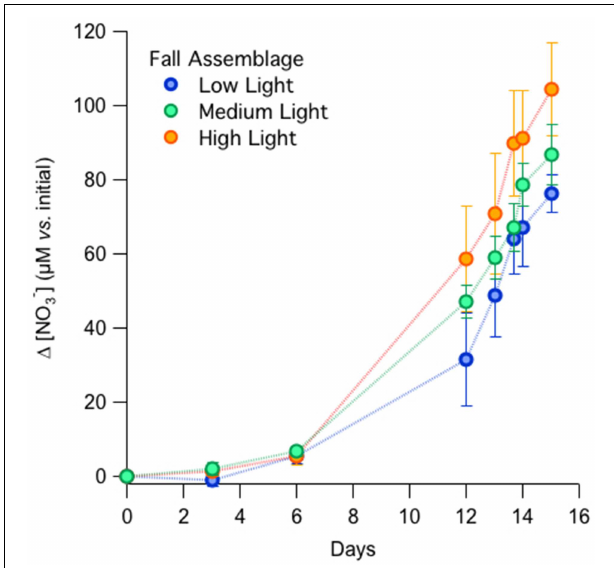
FIGURE 1 | Net NO − 3 consumption among light treatments in the fall incubations.